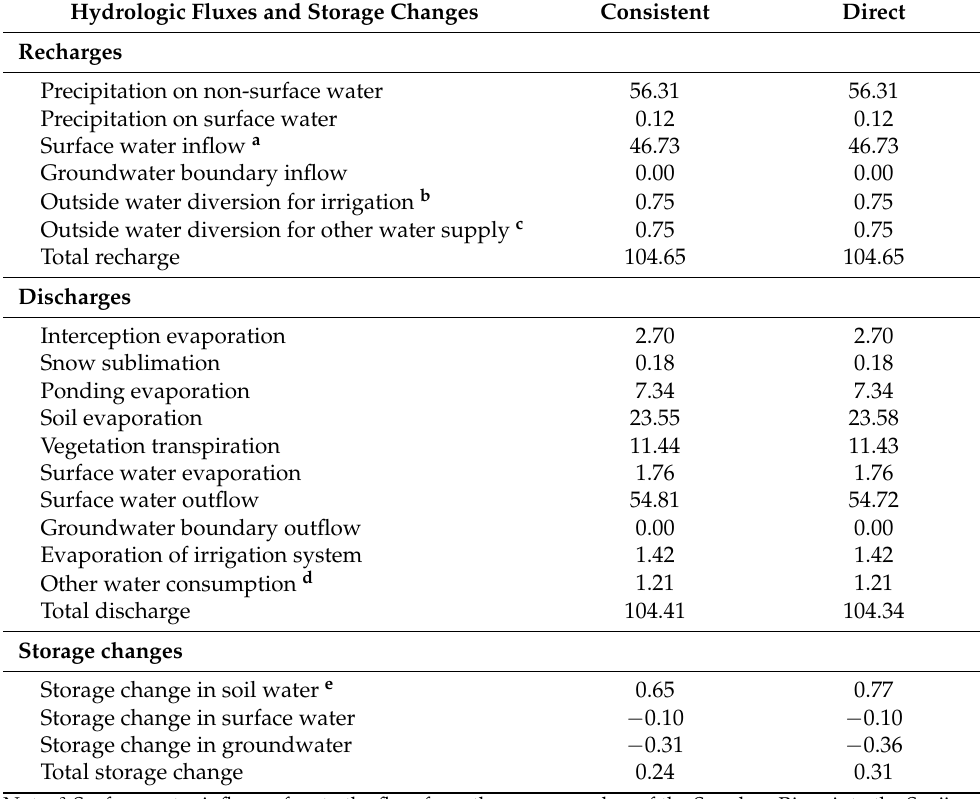
Table 2. Comparison of the average annual water balance from 2002 to 2014 under the consistent transfer and the direct transfer in the Sanjiang Plain (10 9 m 3